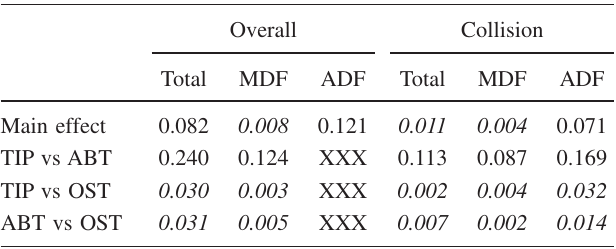
TABLE IV. Probability (cid:1) p (cid:2) values on FMCE gains and improve- ments, computed using ANOVA. Values for the main effect and each post hoc comparison are displayed. Values displayed in italics are significant. For the pushing cluster and the overall ADF values, the main effect was well outside statistical significance; pushing cluster scores are not